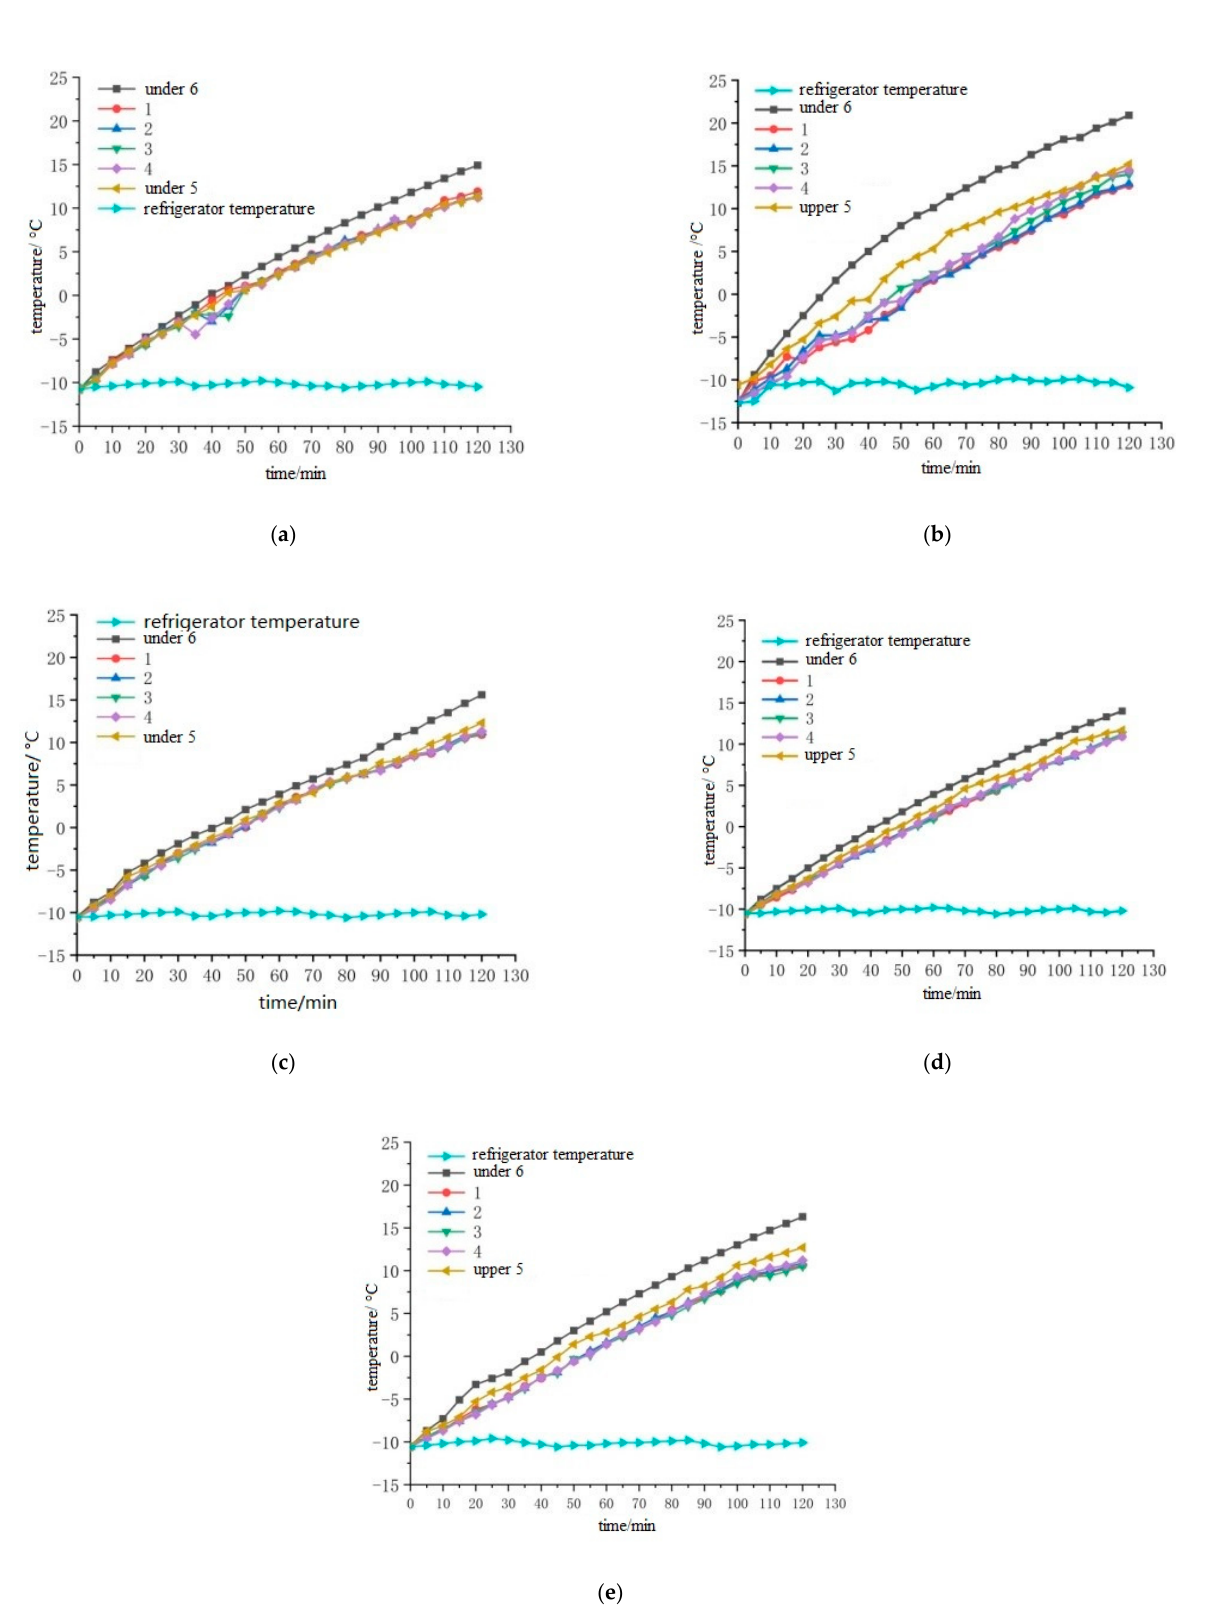
Figure 9. The heating curve of the left and right buried electrodes. ( a ) Temperature rise diagram of left and right straight electrode; ( b ) Temperature rise diagram of left and right mesh electrode; ( c ) Temperature rise diagram of left and right L-shaped electrode with hole; ( d ) Temperature-rise diagram of left and right L-shaped electrode; ( e ) Temperature rise diagram of full-thickness electrode with